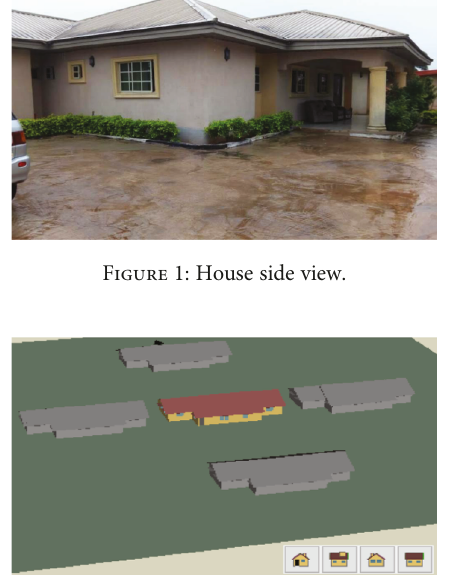
Figure 2: BEopt software house design.